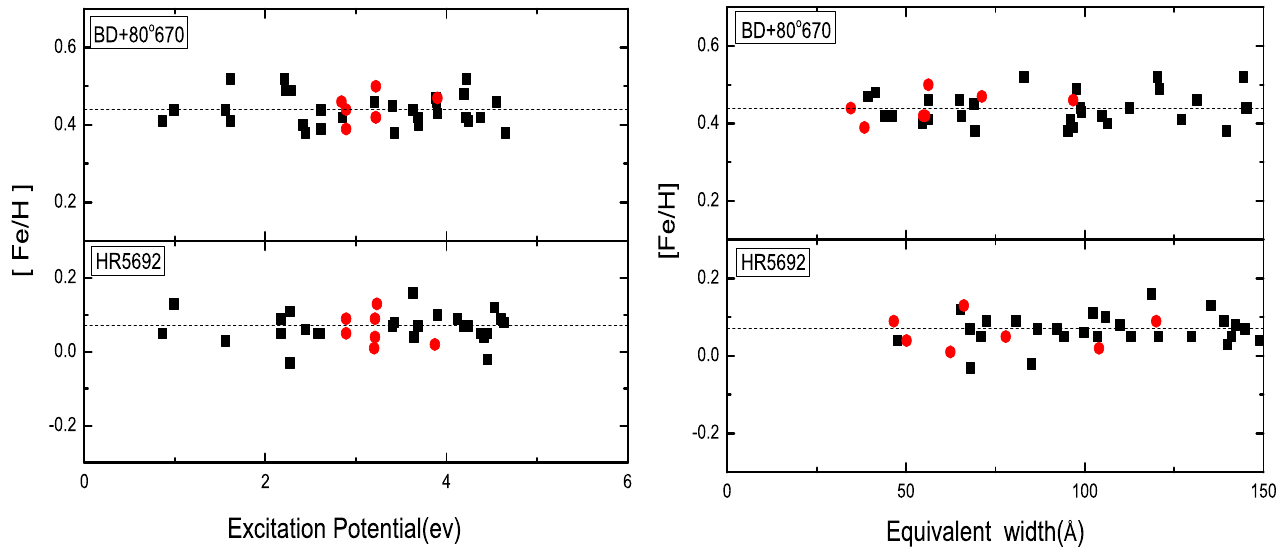
Figure 1. The iron abundances of our sample stars from Fe I NLTE (filled triangles) and Fe II LTE (filled circles) versus excitation potentials ( left ) and equivalent widths ( right